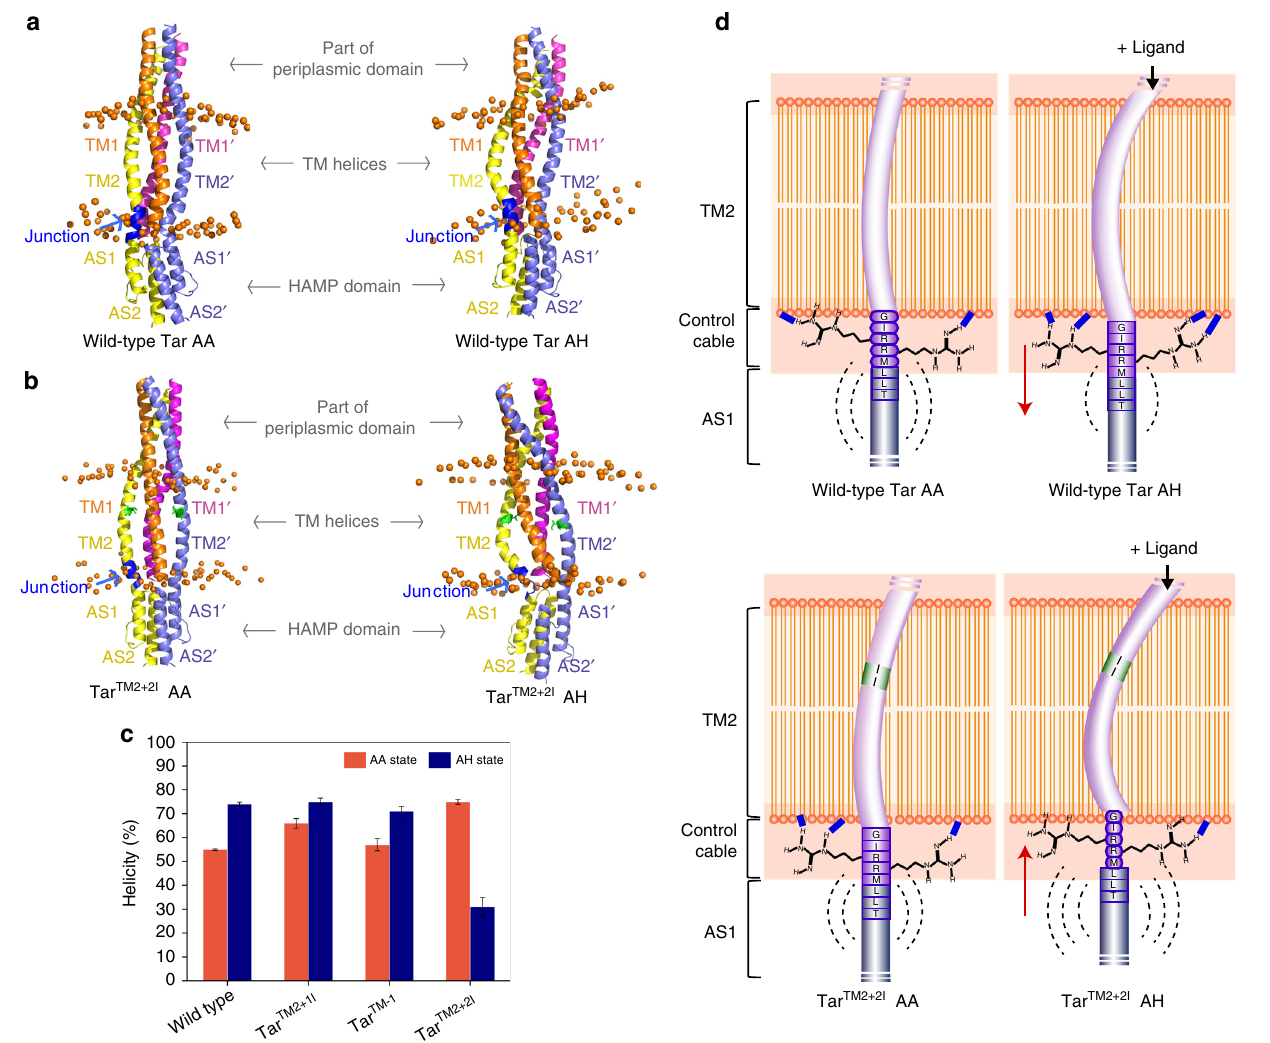
Fig. 2 Mechanisms of signal inversion predicted by MD simulations. a , b Representative structures of AA (ligand-free) and AH (ligand-bound) models for wild-type Tar ( a ) and Tar TM2 + 2I ( b ) averaged from MD simulations. Notations for the helices in the TM and HAMP domains are shown along the structures. In AH states, TM1, TM2, AS1, and AS2 are from the ligand-occupied monomer, while TM1 ′ , TM2 ’ , AS1 ’ , and AS2 ’ belong to the ligand-free monomer. Two isoleucines added in TM2 are shown in green in b . The TM2 – AS1 junction residues 211 GIRRMLLT 218 are shown in blue. DPPC phosphorus atoms are represented as orange spheres to show the solvent – membrane interfaces. The structures were prepared using PyMol. c The helicity of TM2 – AS1 junction residues 211 GIRRMLLT 218 was averaged from three independent MD simulations and compared between wild-type Tar, Tar TM2-1 , Tar TM2 + 1I , and Tar TM2 + 2I , shown as mean ± standard deviation. In the AH state, the helicity of the junction region from the ligand-occupied monomer was analyzed. d Schematic model of signal transduction to the HAMP domain and its inversion in Tar TM2 + 2I . The ligand-promoted bending of TM2 triggers the inward shift of the control cable and AS1 in Tar and strengthens protein – lipid electrostatic interactions, which increase the helicity of the TM2 – AS1 junction region and decrease the conformational dynamics of the control cable and the AS1 of HAMP domain. The outward shift of the control cable and AS1 in Tar TM2 + 2I induces opposite changes. The longitudinal displacement of the control cable and AS1 is highlighted using red arrow. The interactions of R213 and R214 are shown in blue lines. The conformational dynamics of the control cable and AS1 are represented in dash